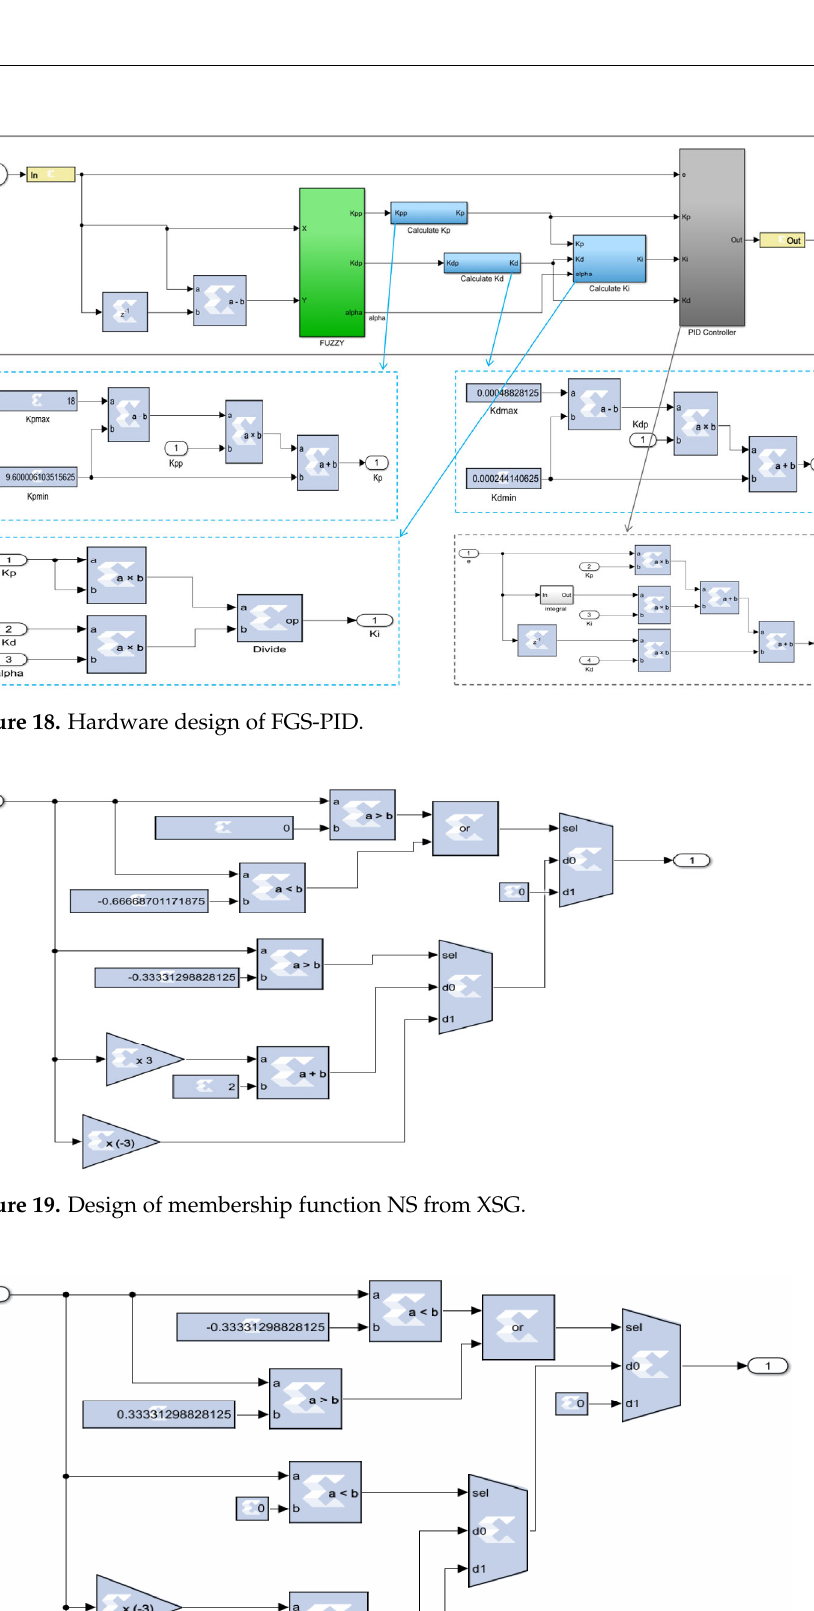
Figure 19. Design of membership function NS from XSG.